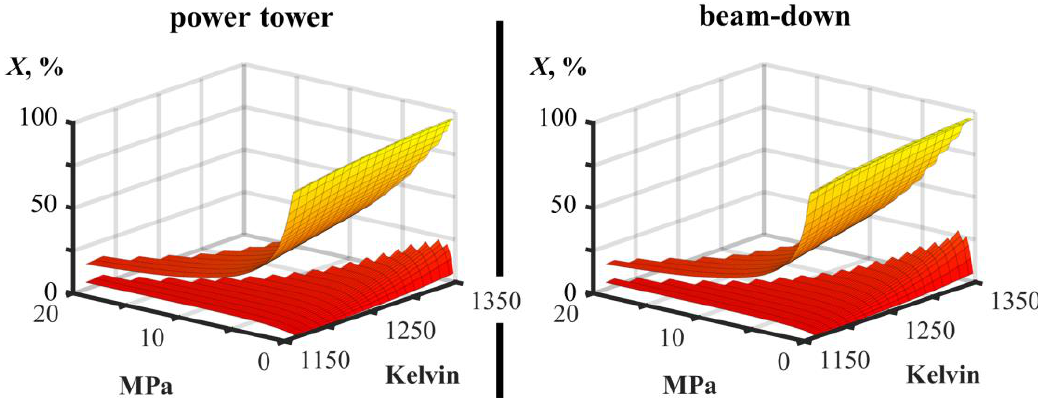
Figure 9. Approach to equilibrium in the power tower and beam-down reactor designs. The upper surface shows maximum theoretical conversion X at reactor effluent temperature and pressure. The lower surface shows actual conversion in the effluent of simulated reactors.